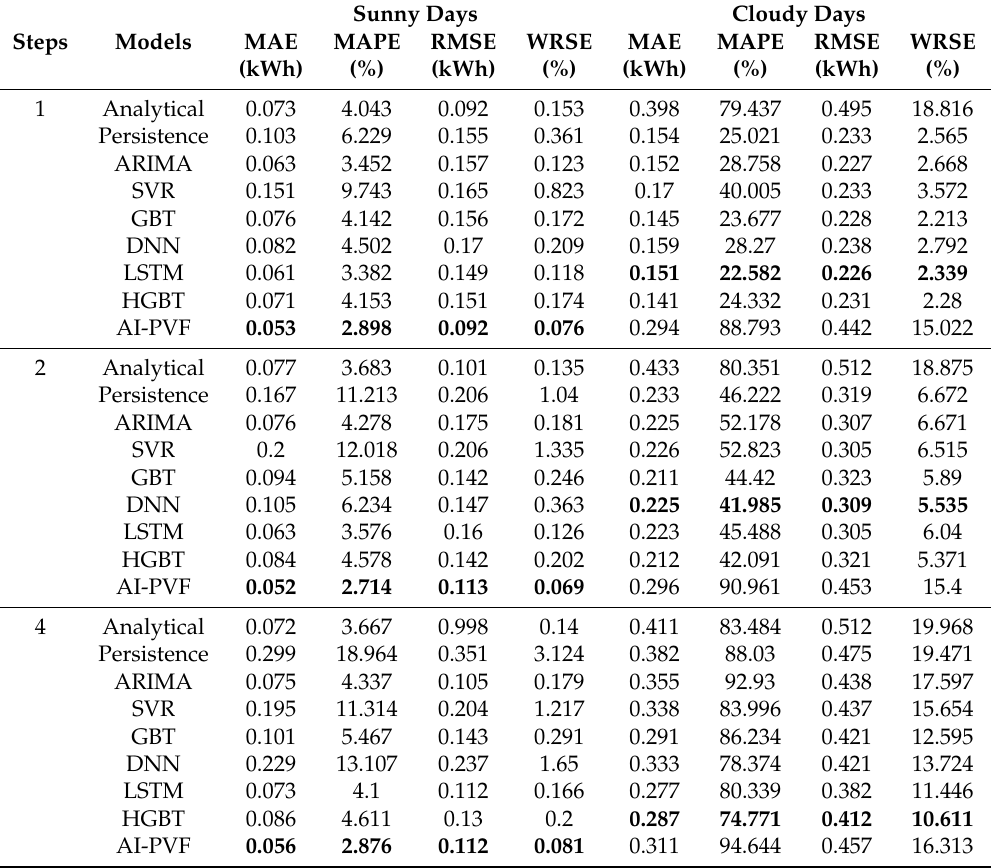
Table 3. Forecasting accuracy results for the spring